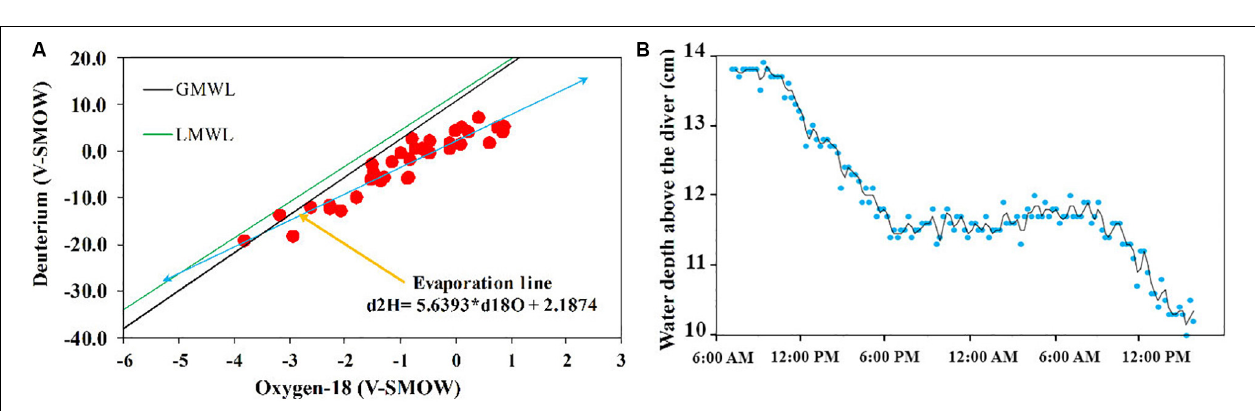
FIGURE 5 | (A) Hydrograph at sand river gate gauge site; (B) flow responses based on individual rain events; (C) recharge and flood dynamics; and (D) losses in the sand storage due to evaporation and transpiration, as well as other losses to vertical and lateral flow. Surface water and Groundwater monitoring were undertaken at the site indicated in Figure 2 . However, historical measurements were for the existing gage station further downstream.